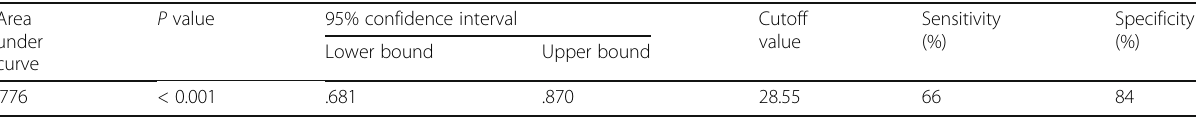
Table 11 AUC, cutoff value, sensitivity, and specificity of total serum bilirubin for detection of neurological dysfunction Area under curve